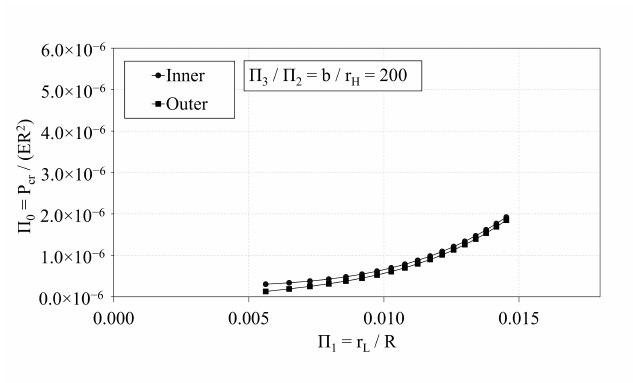
Figure 15. Π 0 vs. Π 1 of OLC and ILC [26].